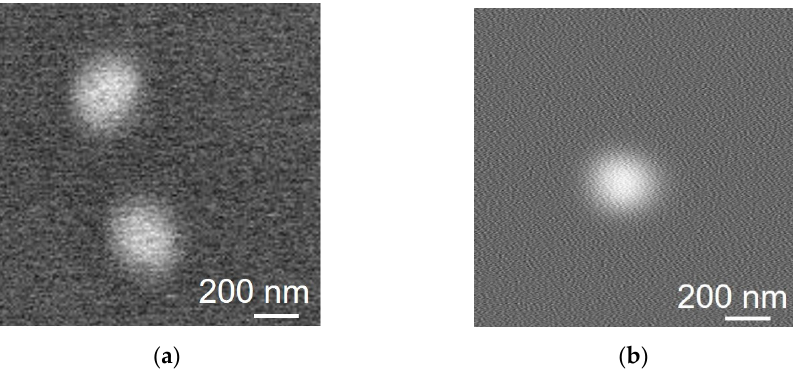
Figure 8. SEM images of T4 bacteriophage through the super thin ETM. ( a ) T4 bacteriophage on the ETM. ( b ) T4 bacteriophage through the super thin ETM.